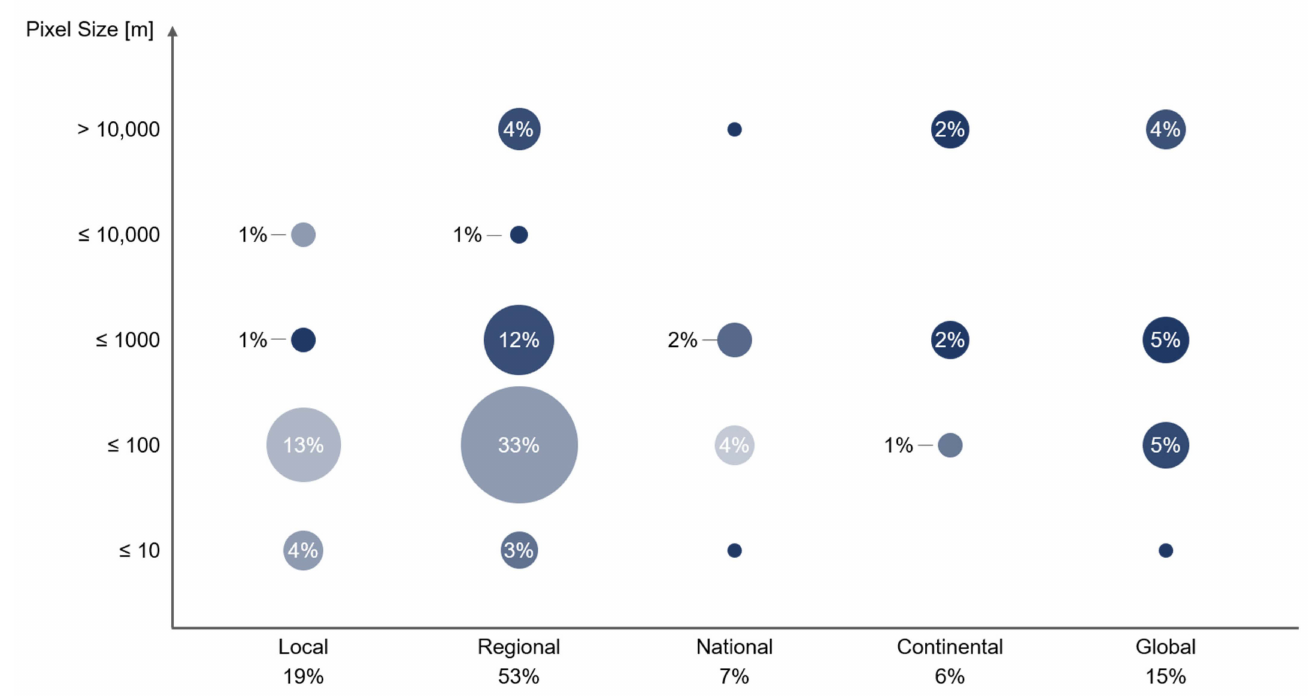
Figure 6. Visualization of spatial resolution versus study area size. Share of all included works is expressed in the area of scatter points and indicated as percentage values for each scatter point. Additionally, color shading from light to dark blue expresses the share of studies within a particular group that consider intra-annual dynamics. The darker the shading, the more studies of this group are considered intra-annual dynamics. For example: 100% of studies have a spatial resolution of ≤ 1000 m and global coverage analyze intra-annual dynamics, while only 30% of studies have a spatial resolution of ≤ 100 m and local coverage consider intra-annual